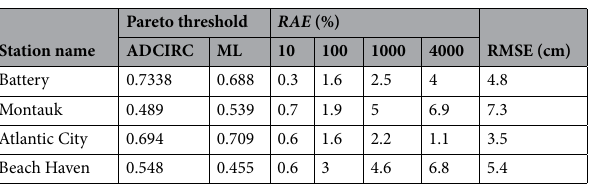
Table 3. Comparison of Pareto thresholds and return period results at the four stations using ADCIRC + SWAN and ML